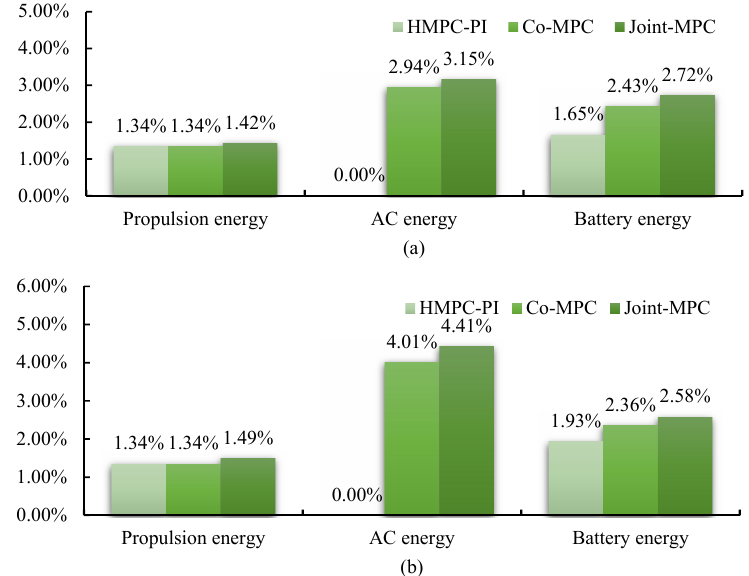
Figure 10. Energy benefits of the different methods compared to the CS-PI in the first case study. ( a ) Fresh-air mode; ( b ) Recirculation mode.